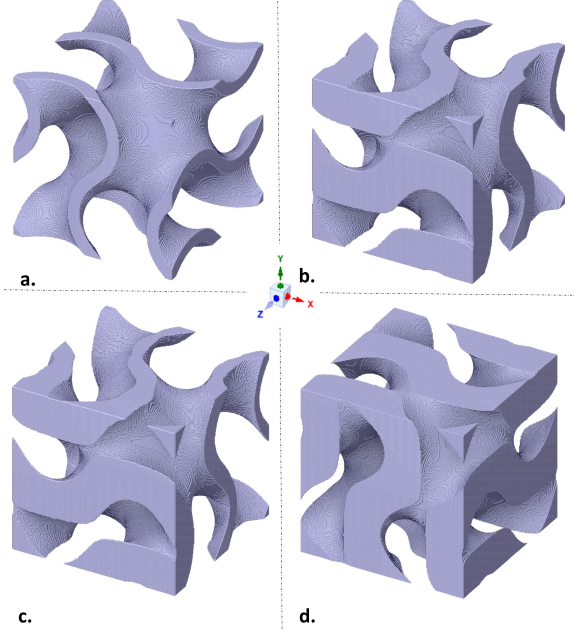
Figure 3. Unit cell of the gyroid structure; gradient with ( a ) constant function, with a porosity of 0.8; ( b ) linear function, with a porosity from 0.4 to 0.8; ( c ) quadratic function, with a porosity from 0.4 to 0.8; ( d ) constant function, with a porosity of